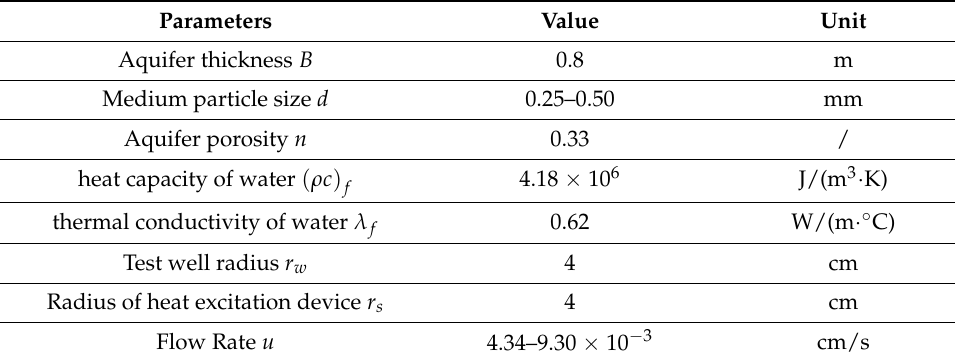
Table 1. The test platform parameters and the calculated parameters